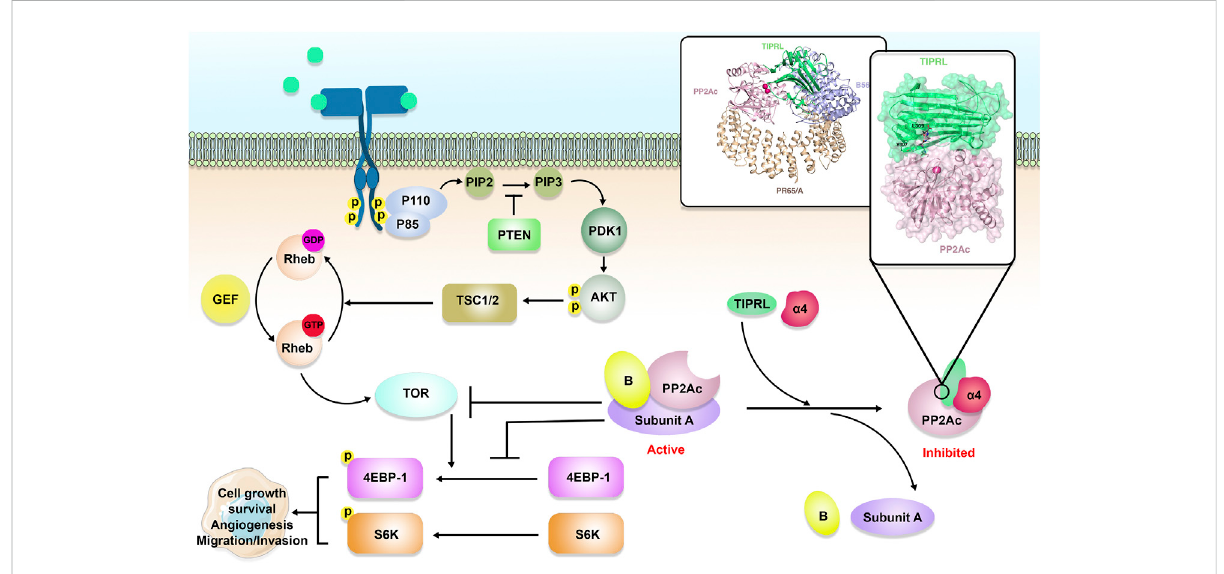
FIGURE 2 The role of the TIPRL/PP2A axis in cancer development. PP2A is comprised of a scaffold, a regulatory, and a catalytic (C or PP2Ac) subunit, a variableBsubunitthatcomesfromfourmajorfamilies,includingB,B ′ ,B ″ ,andB ‴ .PP2Aholoenzyme,asatumorsuppressor,caninhibitMYC,Cyclin- dependentkinase1(Cdk1),B-celllymphoma2(Bcl-2),Extracellularsignal-regulatedkinase(ERK),wnt/ β -catenin,andeukaryotictranslationinitiation factor 4E (eIF4E). In addition to inhibition of PP2A, TIPRL can also participate in TRAIL-induced apoptosis and subsequent phosphorylation of MAP kinase 7 (MKK-7) and c-Jun N-terminal kinase (JNK), resulting in cancer cell